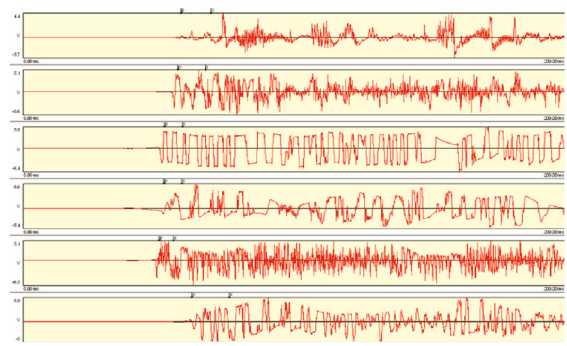
Figure 32: Strong rock burst waveform (9 October 2009 in a